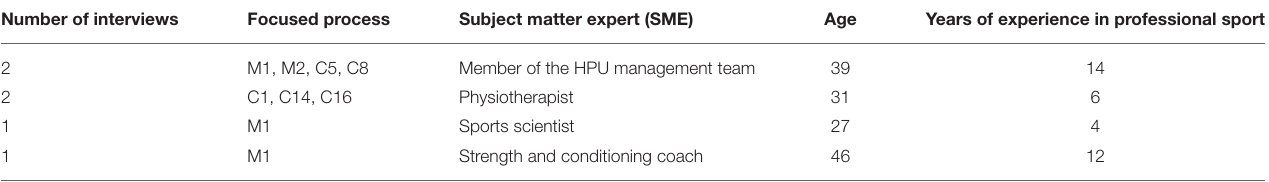
Number of interviews